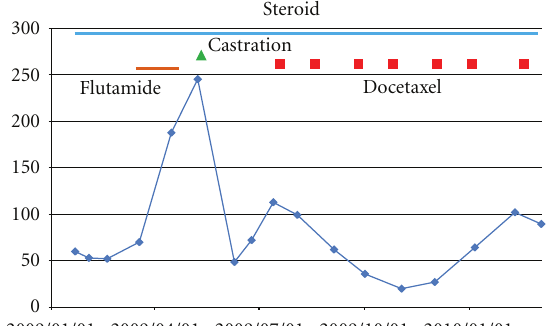
Figure 3: PSA course after 2009/1/1 of the patient described in Figure 2 is enlarged. After surgical castration, docetaxel (70mg/m 2 per course every three weeks) was administered together with zoledronic acid